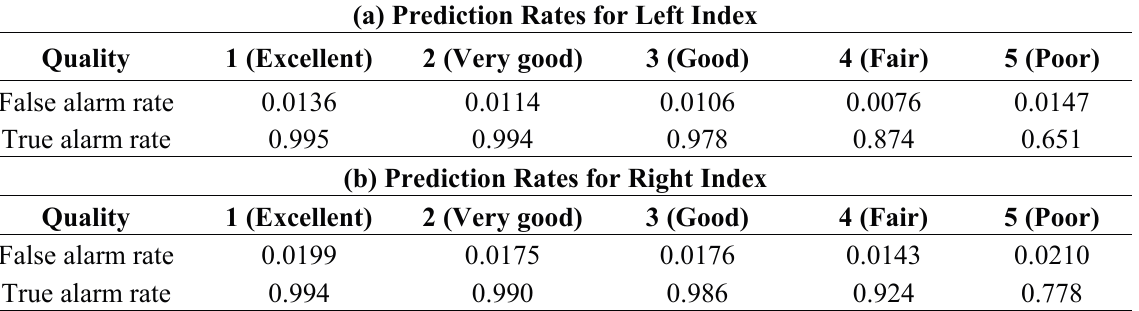
Table 2. Prediction accuracies on (a) left index; (b) right index at various NFIQ levels. (False alarm rate: fingerprints were matched incorrectly; True alarm rate: fingerprints were matched successfully. Data from NIST